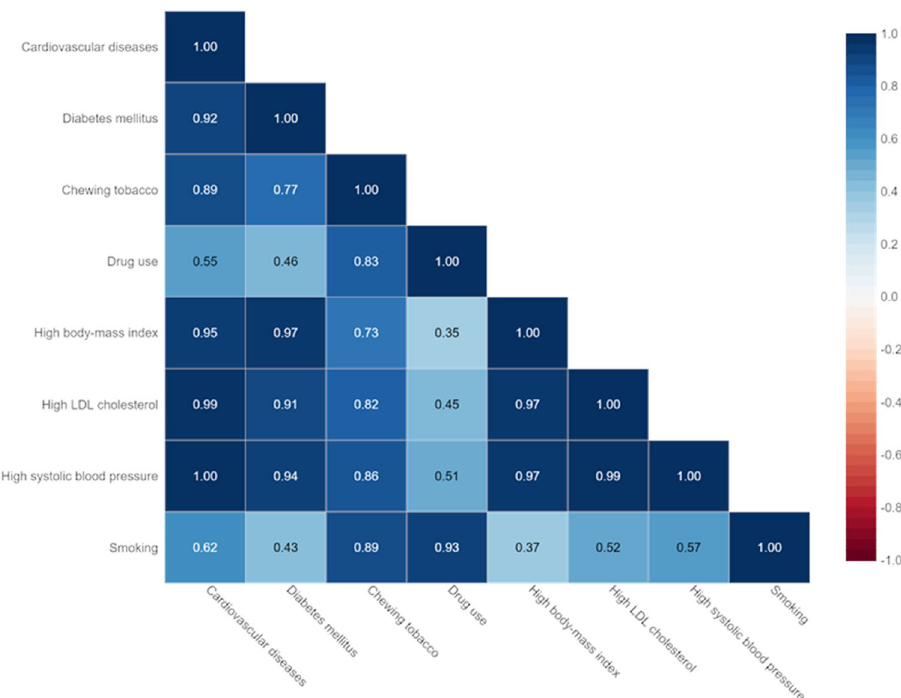
Figure 10. Relationship between CVD mortality and prevalence of CVD risk factors (DM2, tobacco and drug use, high BMI, high LDL cholesterol, high SBP, and